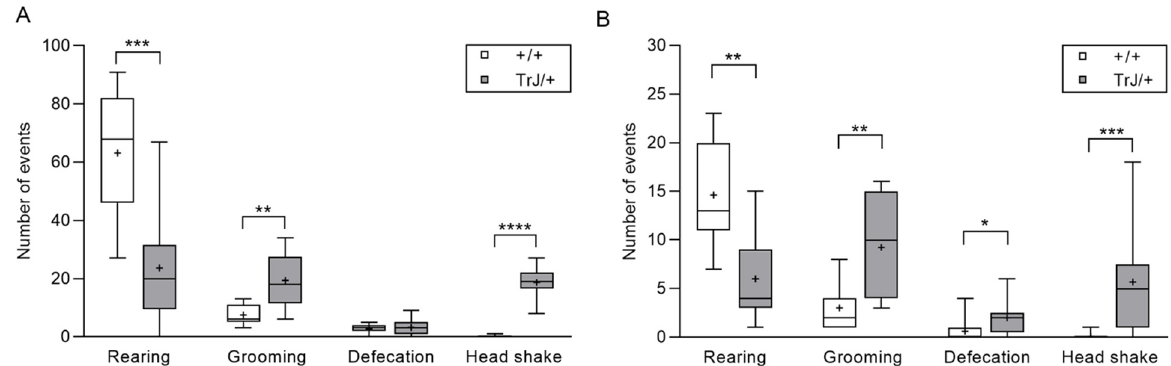
Figure 2. Rearing, grooming, defecations, and head shake of +/+ mice and TrJ/+ mice. ( A ) Parameters analyzed in open field test. ( B ) Parameters analyzed in elevated plus maze test. Rearing and grooming behaviors were analyzed using Student’s t -test, df = 18. Defecations and head shake were analyzed using the Mann–Whitney U-test. Asterisk indicates significant difference between TrJ/+ (gray bars, n = 9) and +/+ (white bars, n = 11) mice: * p < 0.05, ** p < 0.01, *** p < 0.001, **** p < 0.0001. The mean is shown as “+”.